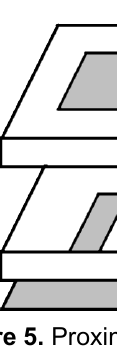
Figure 5. Proximity coupling feed